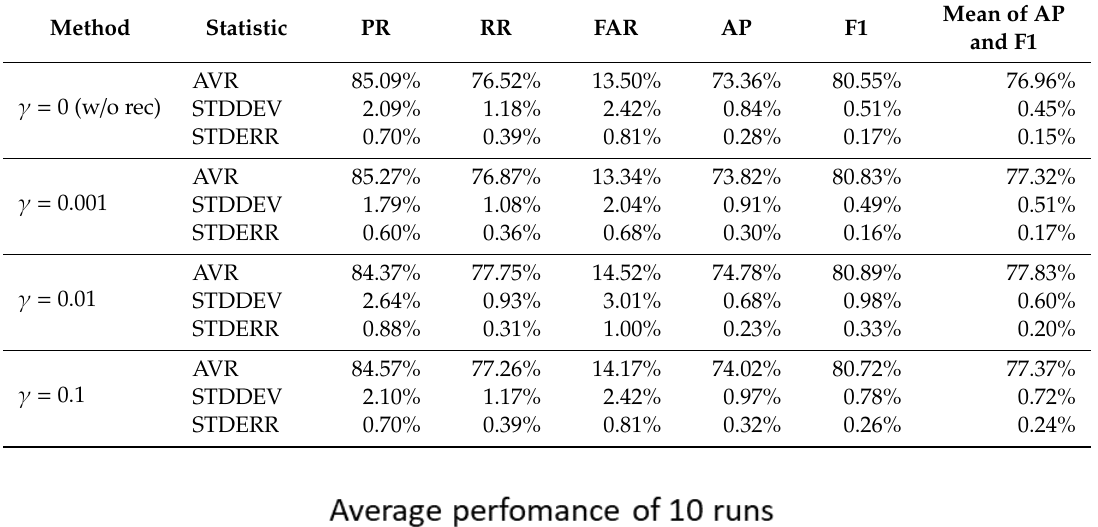
Table 3. All statistics of repeated experiments 10 times.